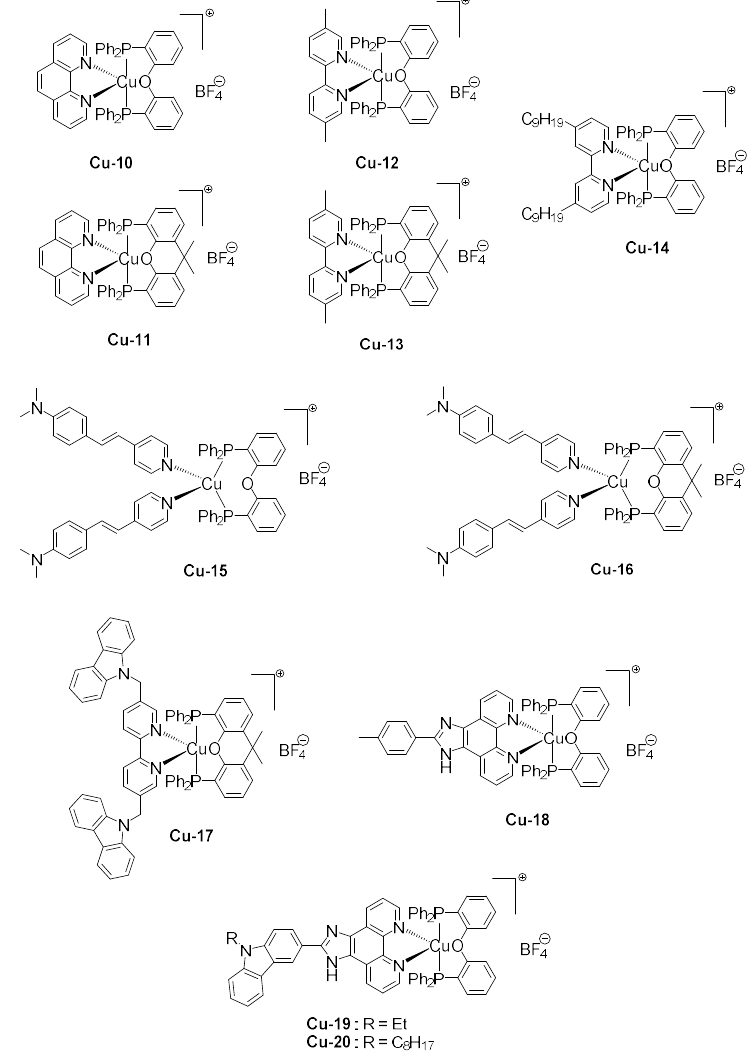
Figure 8. Chemical structures of Cu-10 – Cu-20 .